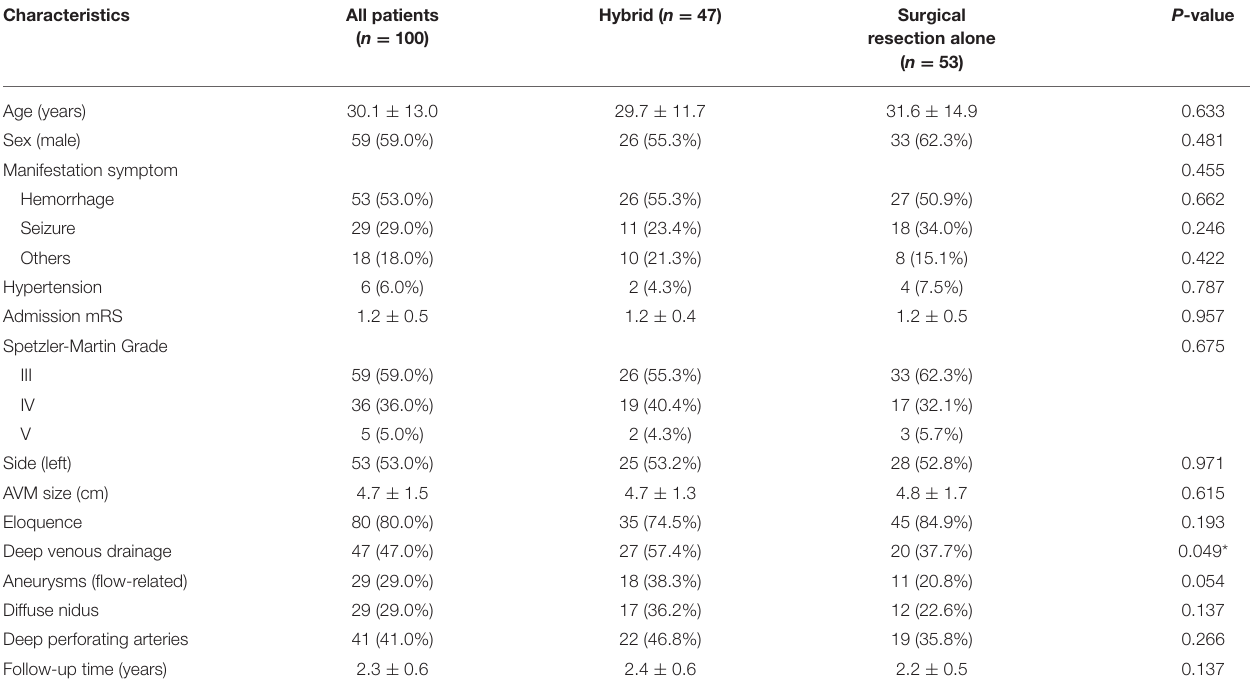
TABLE 1 | Baseline demographic and angiographic characteristics.